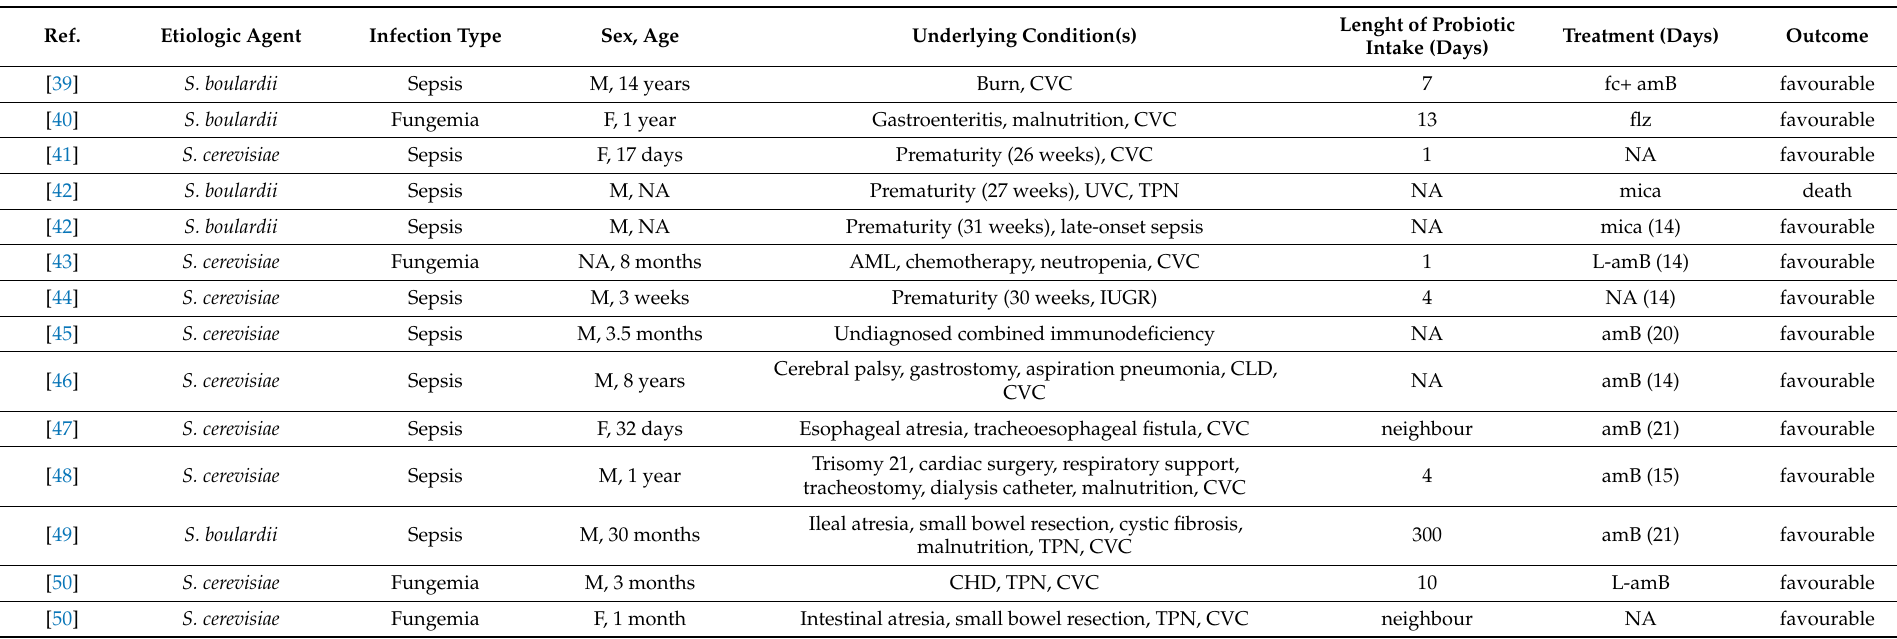
Table 2. Clinical and microbiologic features of 14 paediatric patients with Saccharomyces spp. ( S. spp.) invasive infections after use of probiotics.